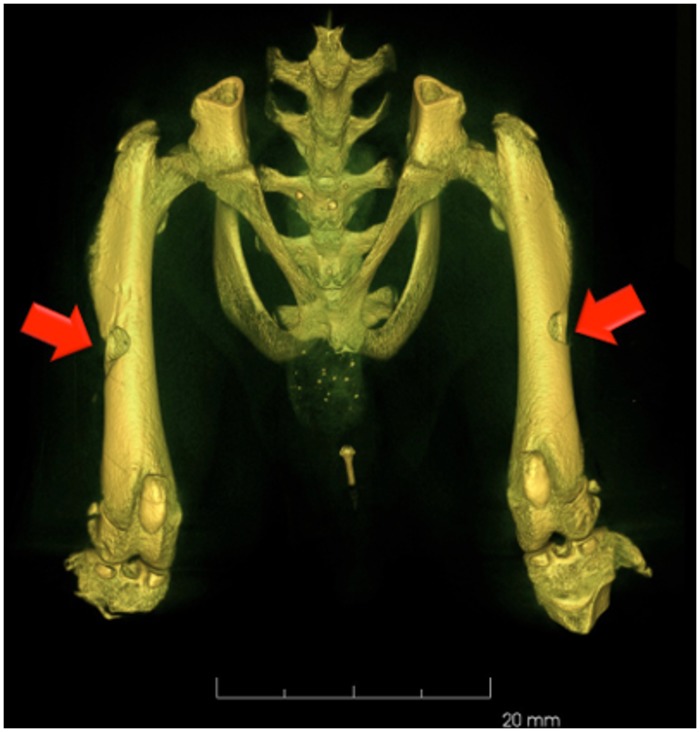
In vivo micro-CT image acquired after the surgical procedure showing the size and extent of the lesions.